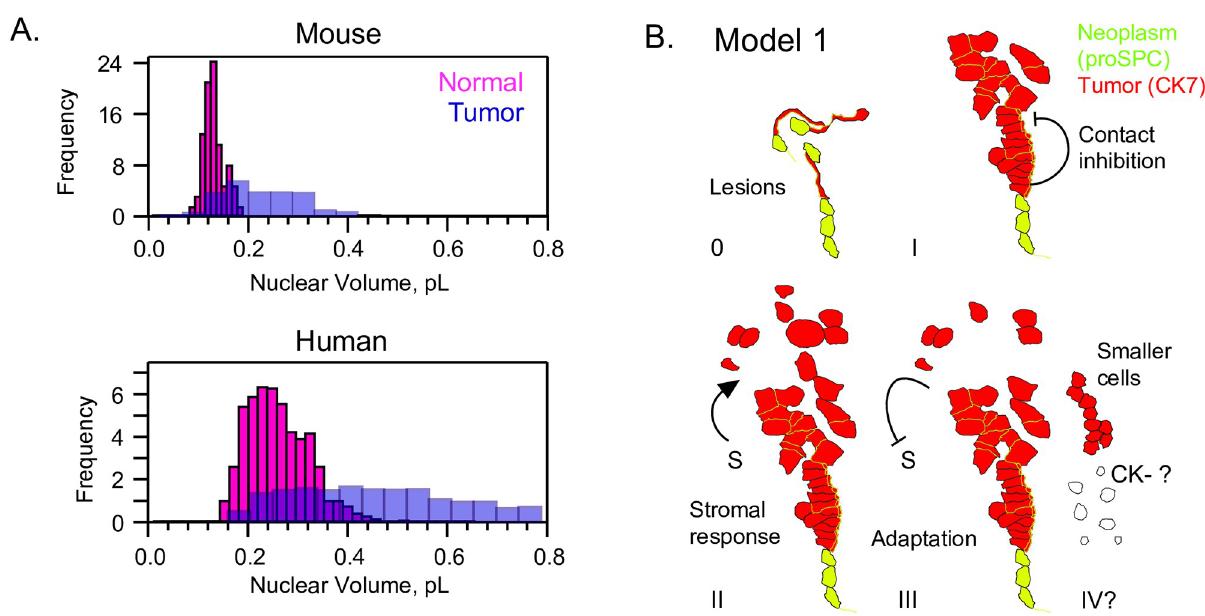
Fig 9. Epithelial cell-size dysregulation is also found in mouse tumors and may proceed with loss of tissue organization and upregulation of transcription. A., KrasLSL-G12D/+; p53fl/fl; Rosa26LSL-eYFP/LSL-eYFP mouse lung tissue shows nuclear size dysregulation, despite volumes of ~50% that of humans. B., Model 1: Oncogenesis is characterized by lesions, loss of flattening to an AT1 form and thus shortening of processes. At stage I, a contact-dependent mechanism preserves some cell size regulation. Stage II involves more mixed stroma/tumor regions and disorganization, leading to sparse cells and increased cell size dysregulation. Late stage (III-IV) cancers are dominated by adaptation towards maximal cell division rate, evolution of immune resistance, and also loss of cytokeratin staining. Smaller cells, and those of the more subproportional volume:ploidy relationship in KRAS + cancers (Fig 3) may become enriched in late stages.